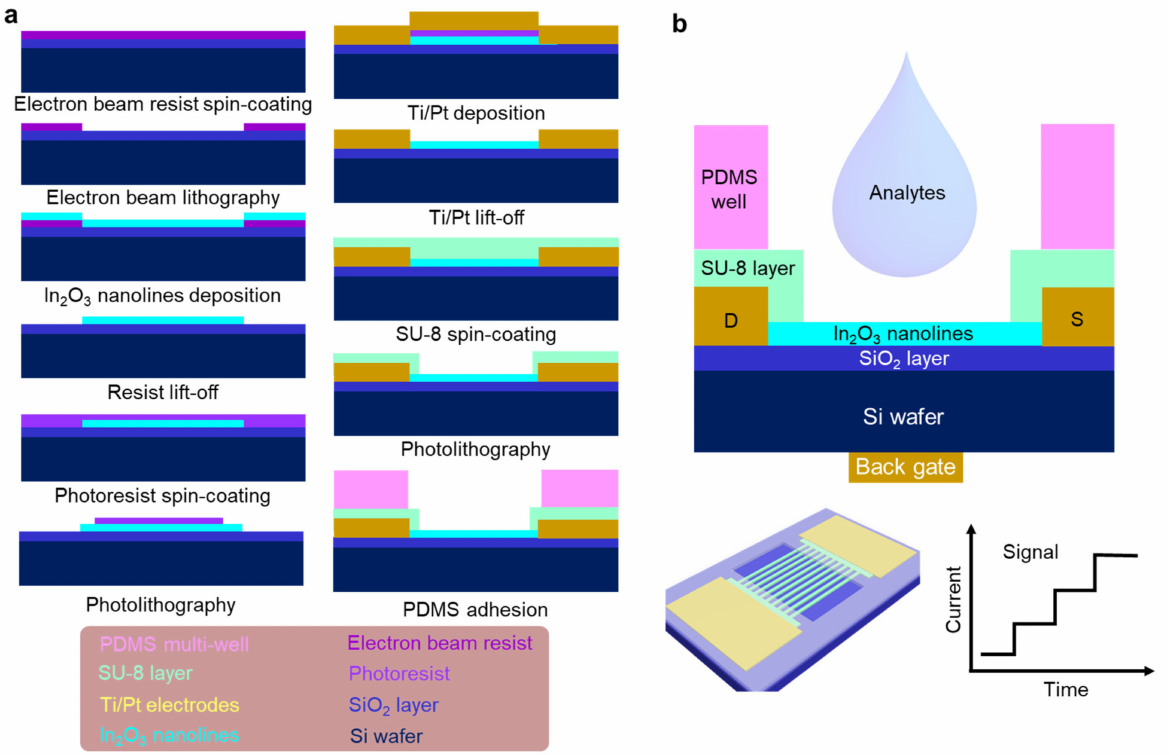
Figure 1. ( a ) Flowchart of the fabrication process of In 2 O 3 nanolines on Si/SiO 2 substrate. The materials used in the fabrication are colored-coded in the key. ( b ) Schematic drawings of a cross section and a top view. The signal curve (response) plot of current vs. time when changing the